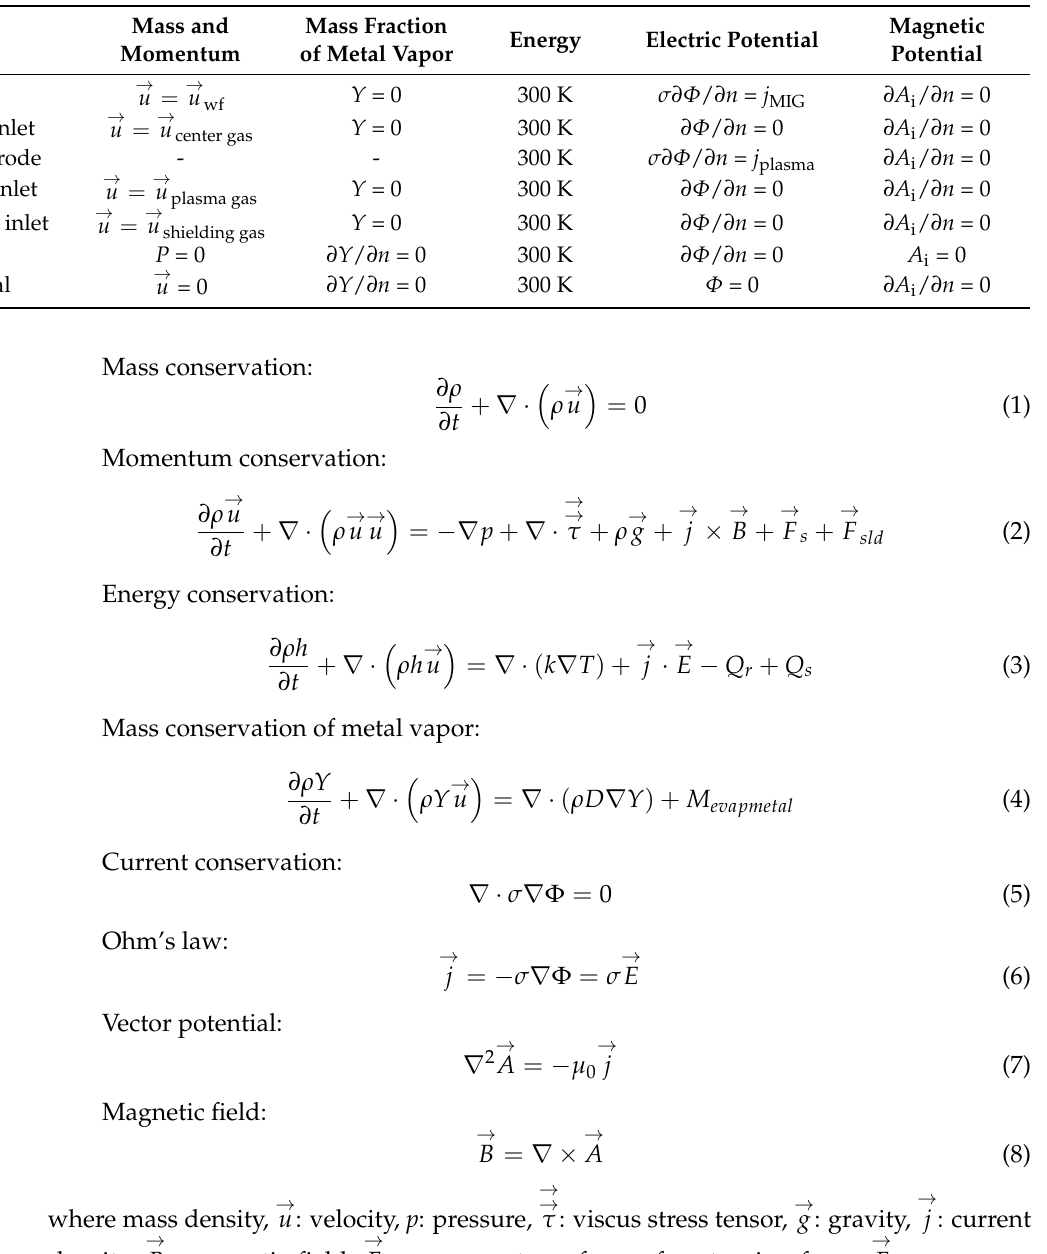
Table 2. Boundary